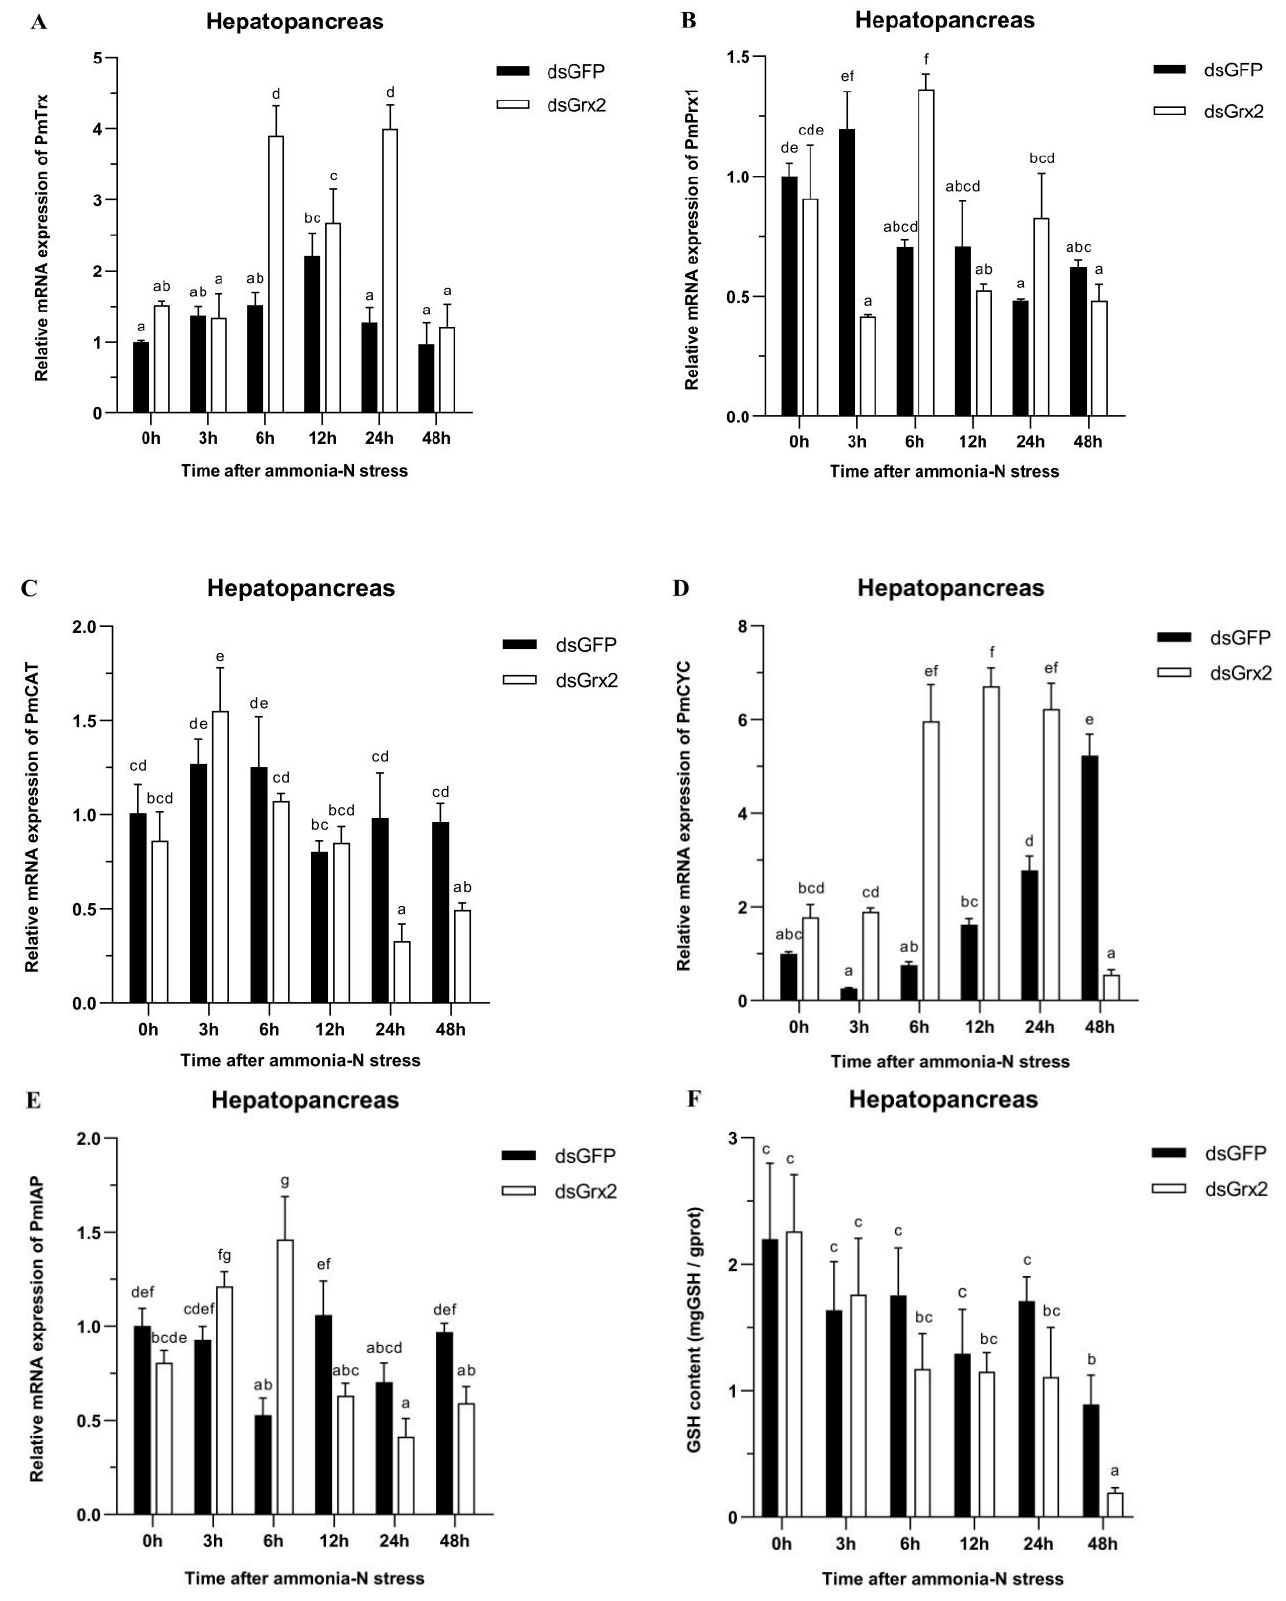
Figure 6. Expression profiles of five genes ( PmTrx ( A ), PmPrx1 ( B ), PmCAT ( C ), PmCYC ( D ), and PmIAP ( E )) and changes in GSH content ( F ) in the hepatopancreas of dsRNA-injected shrimps under ammonia-N stress. The data are presented as mean ± SD (n = 3). Different letters show significant differences ( p < 0.05).